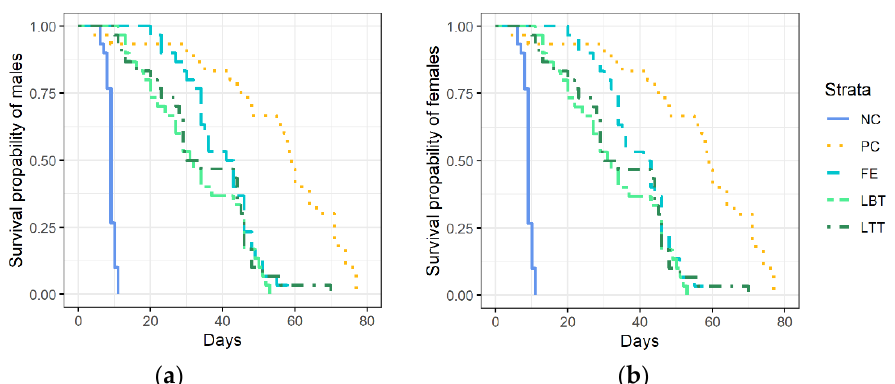
Figure 1. Survival of ( a ) male and ( b ) female Trichopria drosophilae when provided with different diets (NC = water, negative control, PC = honey, positive control; flowers of FE = Fagopyrum esculentum , LBT = Lobularia maritima ‘Benthamii’, LTT = L. maritima ‘Tiny Tim’). N = 30 wasps per treatment (=Strata).